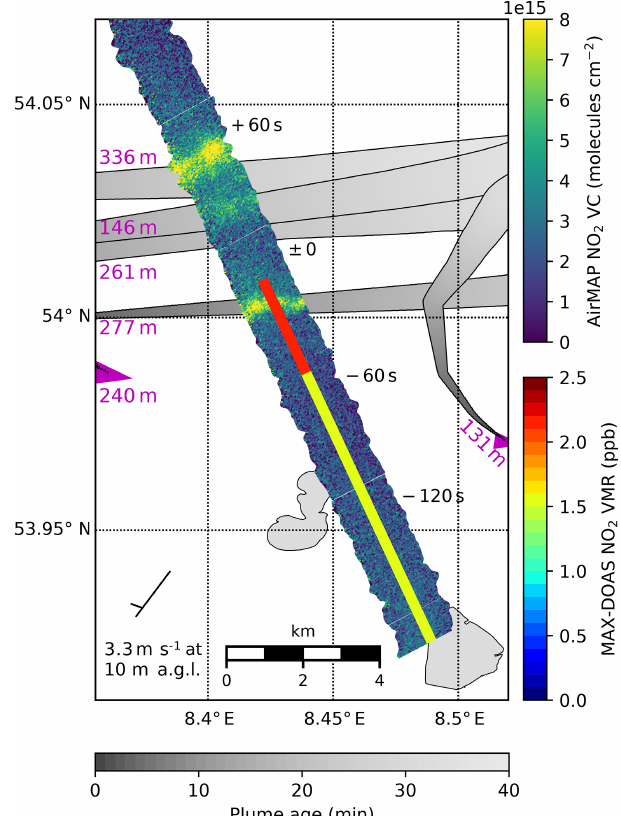
Figure 8. Map showing the MAX-DOAS path-averaged VMRs (colored lines) and AirMAP vertical columns of NO 2 (broad image stripe beneath) on 21 August 2013 around 9:53UTC (11:53LT). As the plotted physical quantities are entirely different (VMRs and columns), color scale agreements are not expected (and completely random). Magenta triangles show current ship positions and course, and magenta numbers denote the ship length. The modeled plumes (for the MAX-DOAS measurement time) are shown in gray, with the lightness of the gray shading representing the plume age. The time difference between AirMAP and MAX-DOAS measurements is indicated in the map at specific parts of the flight track. Wind direction and speed are shown with a meteorological wind